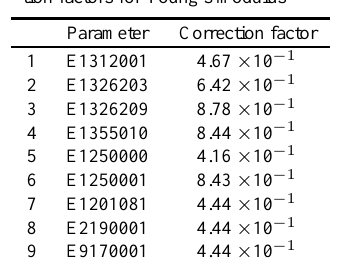
Table 5 The selected parameters and correc-